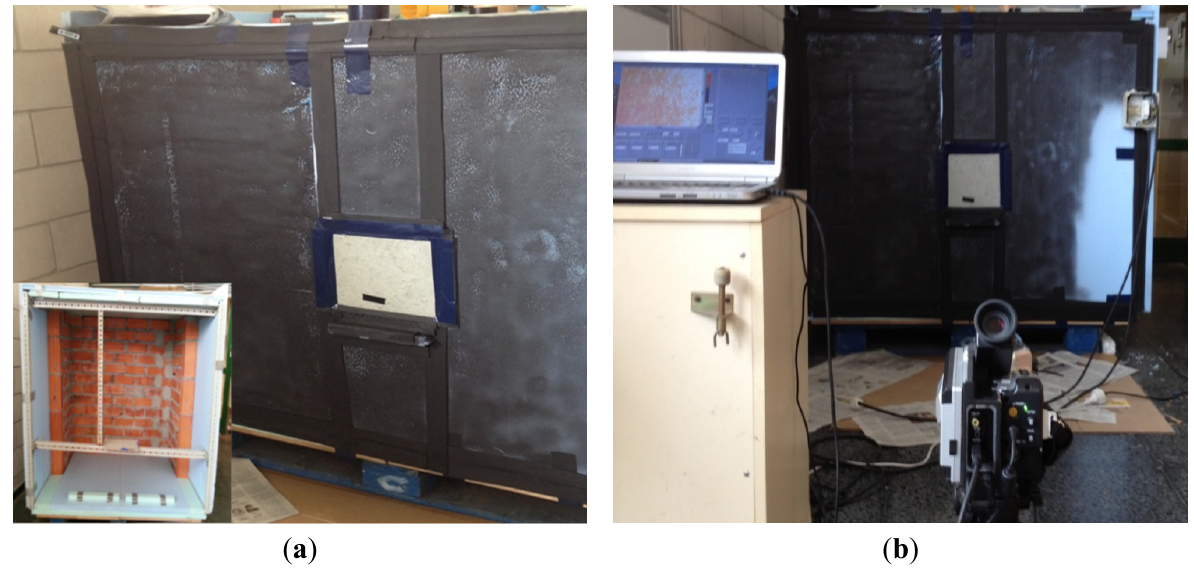
Figure 1. ( a ) Cabin painted black with specimen centered. Bottom left: cabin without the front panel, with support area for the specimen; ( b ) Measuring and recording